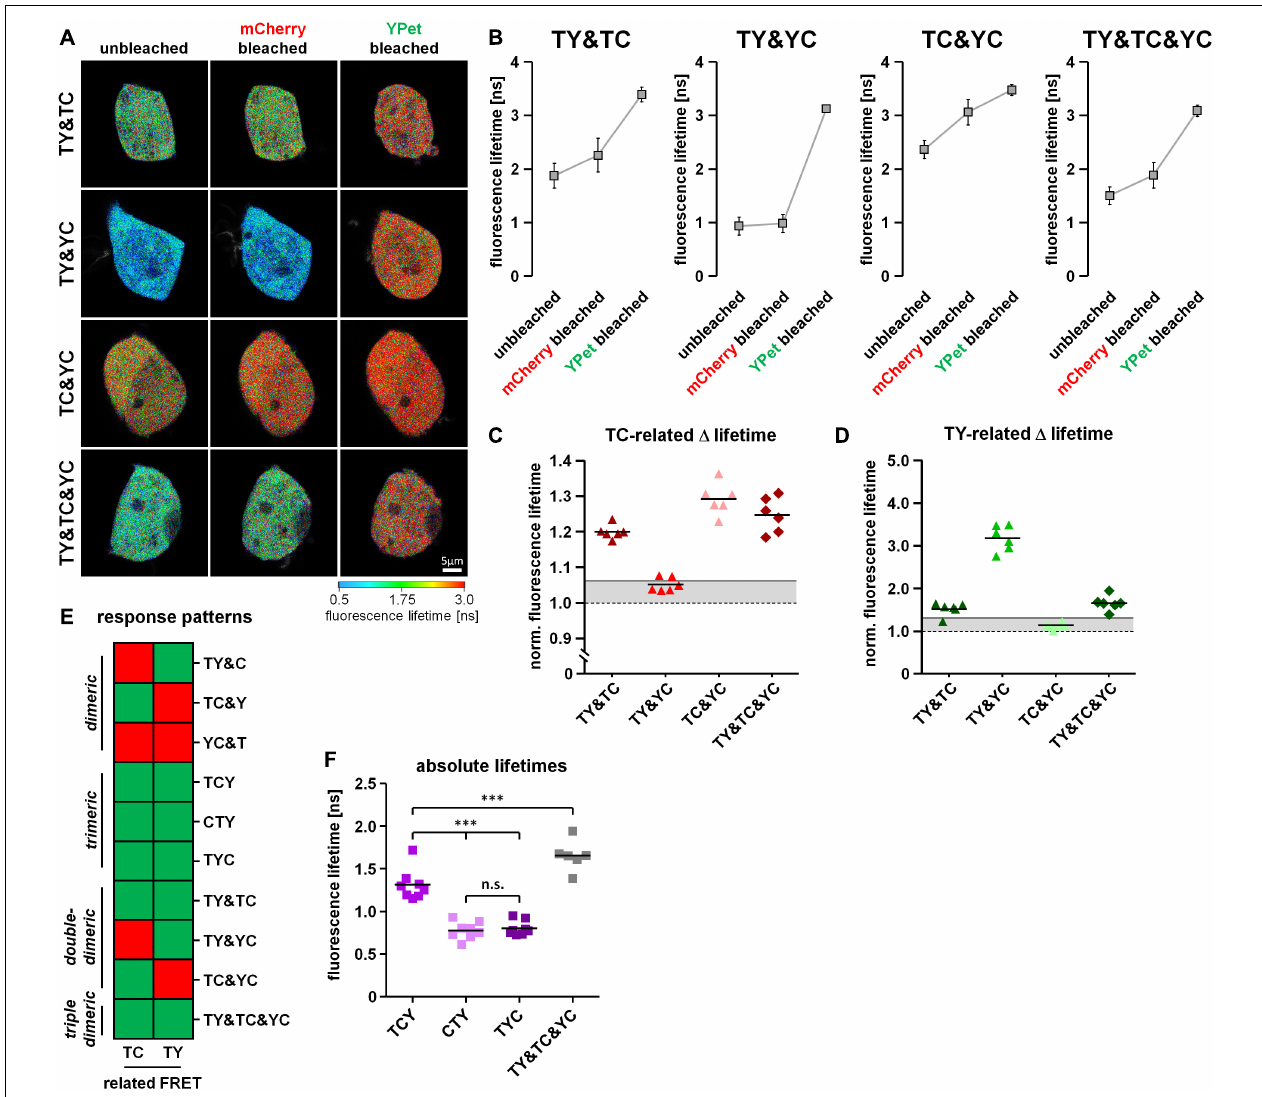
FIGURE 5 | Discrimination of different types of dimeric interactions among three potential interaction partners using fluorescence lifetime-based measurements. (A) Representative images showing the color-coded fluorescence lifetime of mTurquoise2 before bleaching (unbleached), after the first bleaching step (mCherry bleached) and after the second bleaching step (YPet bleached). (B) Change in average amplitude weighted lifetime of the cells during the two-step bleaching protocol ( n = 6). After mCherry bleaching, the fluorescence lifetime increased in TY&TC, TC&YC and TY&TC&YC samples, but remained constant in TY&YC. After YPet bleaching, the fluorescence lifetime strongly increased in TY&TC, TY&YC and TY&TC&YC, but only moderately in TC&YC. (C,D) Relative change in fluorescence lifetime of mTurquoise2 after mCherry bleaching [ (C) , first bleaching step] and the additional relative change in fluorescence lifetime after YPet bleaching [ (D) , second bleaching step] ( n = 6). Gray lines indicate threshold values to discriminate FRET-specific from non-specific lifetime changes of the donor. (E) Updated color-coded response patterns and decision matrix of fluorescence lifetime-based measurements. For each direction of FRET, a Yes-response (occurrence of specific FRET) is indicated by a green and a No-response (no or non-specific FRET) is indicated by a red square. Without information about YC-related FRET, these patterns cannot be used to discriminate dimeric from trimeric and double-dimeric interactions as it was shown for the intensity-based patterns. (F) However, the different basal fluorescence lifetimes of the combination of all three dimers versus each of the FRET triplet constructs allow for their discrimination of multi-dimeric and trimeric interactions which was not possible from the intensity-based